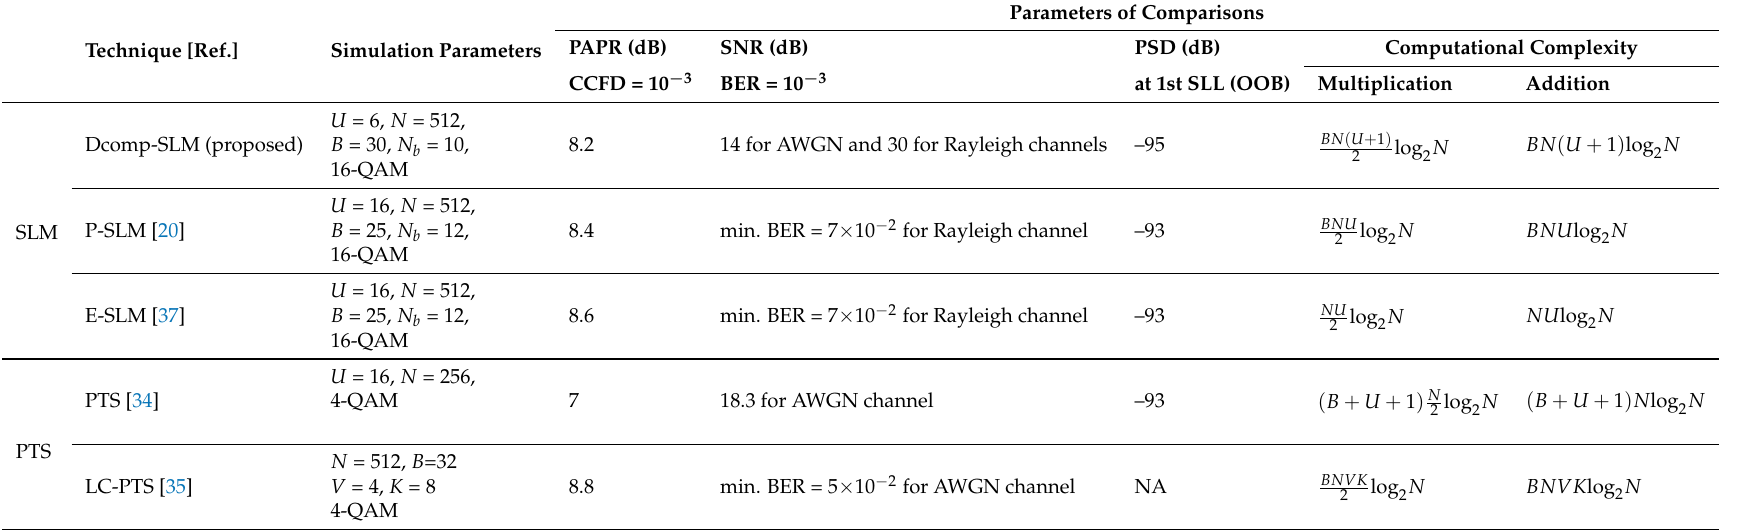
Table 2. Comparison of our work with the related works reported in the